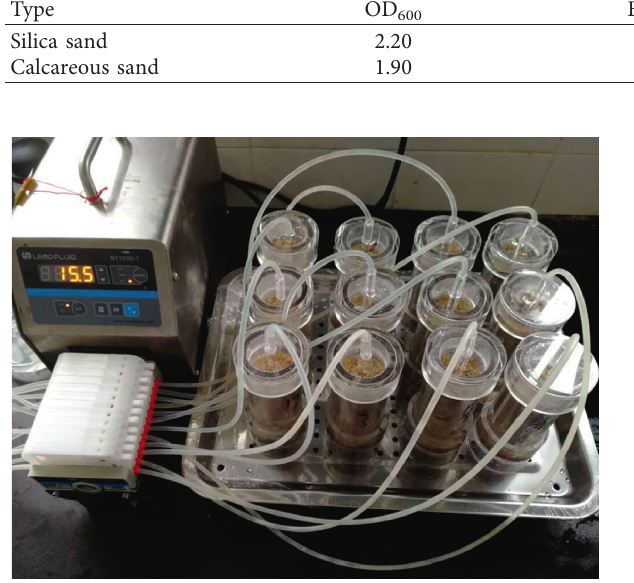
Figure 3: Schematic drawing of the batch reactor.